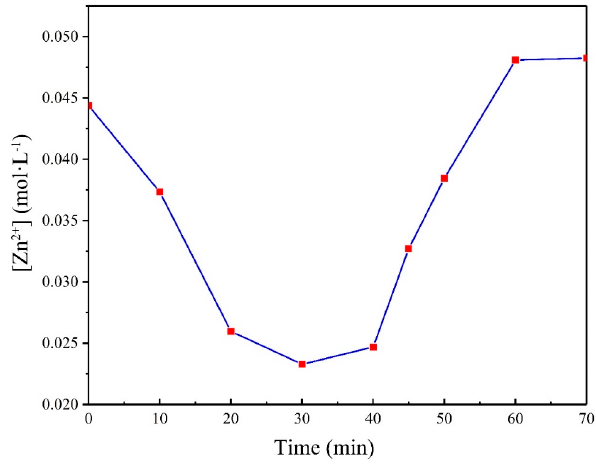
Figure 4. Variation of soluble zinc concentration with reaction